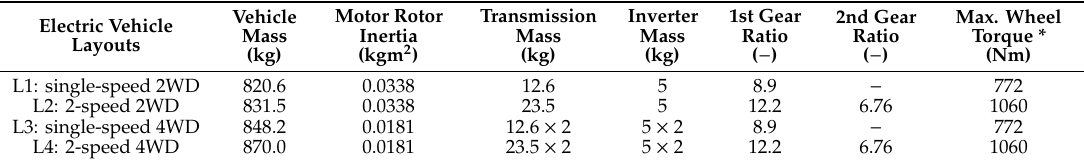
Table 1. Main parameters of the considered EV layouts.